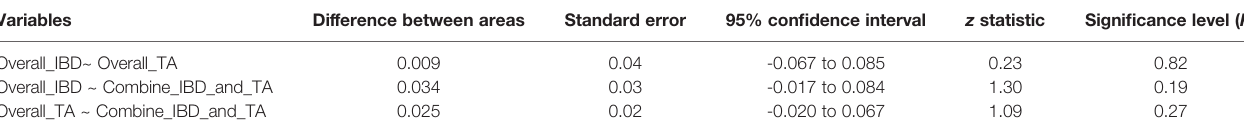
TABLE 6 | Receiver operating characteristic analysis of the overall imaging-based diagnosis (IBD), overall texture analysis (TA), and combined IBD with TA models.